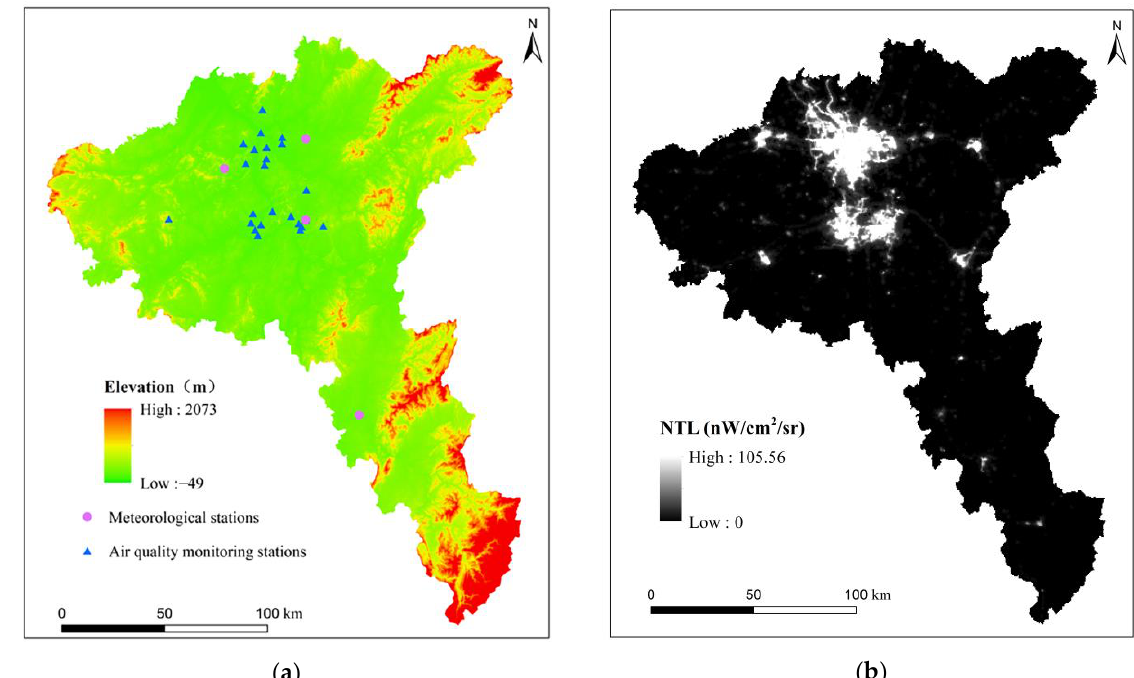
Figure 2. Datasets used in this study. ( a ) SRTM DEM data and spatial distribution of the monitoring stations; ( b ) NPP-VIIRS nighttime light (NTL) image.